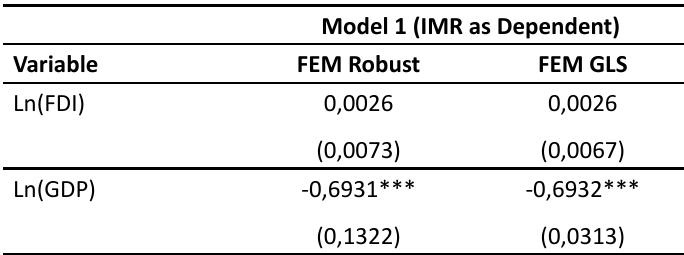
Table 4: Robust Test and FEM